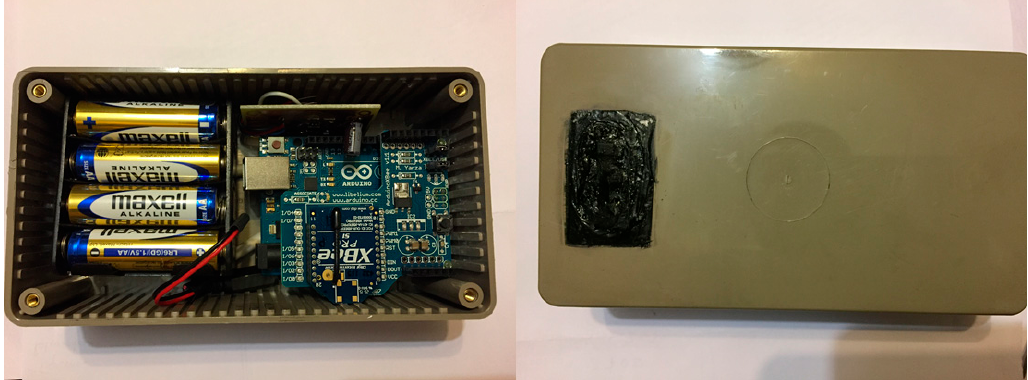
Figure 7. Outdoor module prototype ( left ) and its weather protected temperature sensor ( right ).